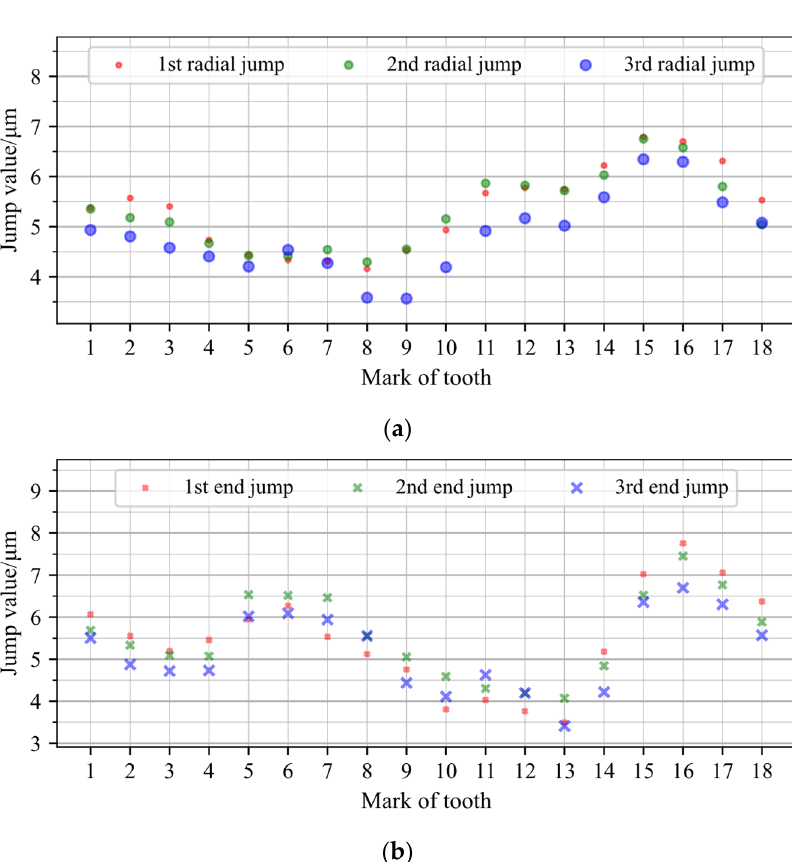
Figure 16. Test results of experimental group 3 after tooth rotation. ( a ) Radial jump; ( b ) end jump.